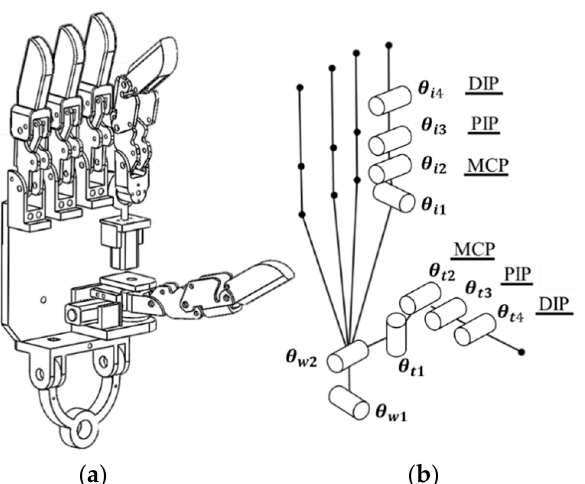
Figure 1. Schematics of ( a ) the design and ( b ) the kinematic structure of the model anthropomorphic hand.